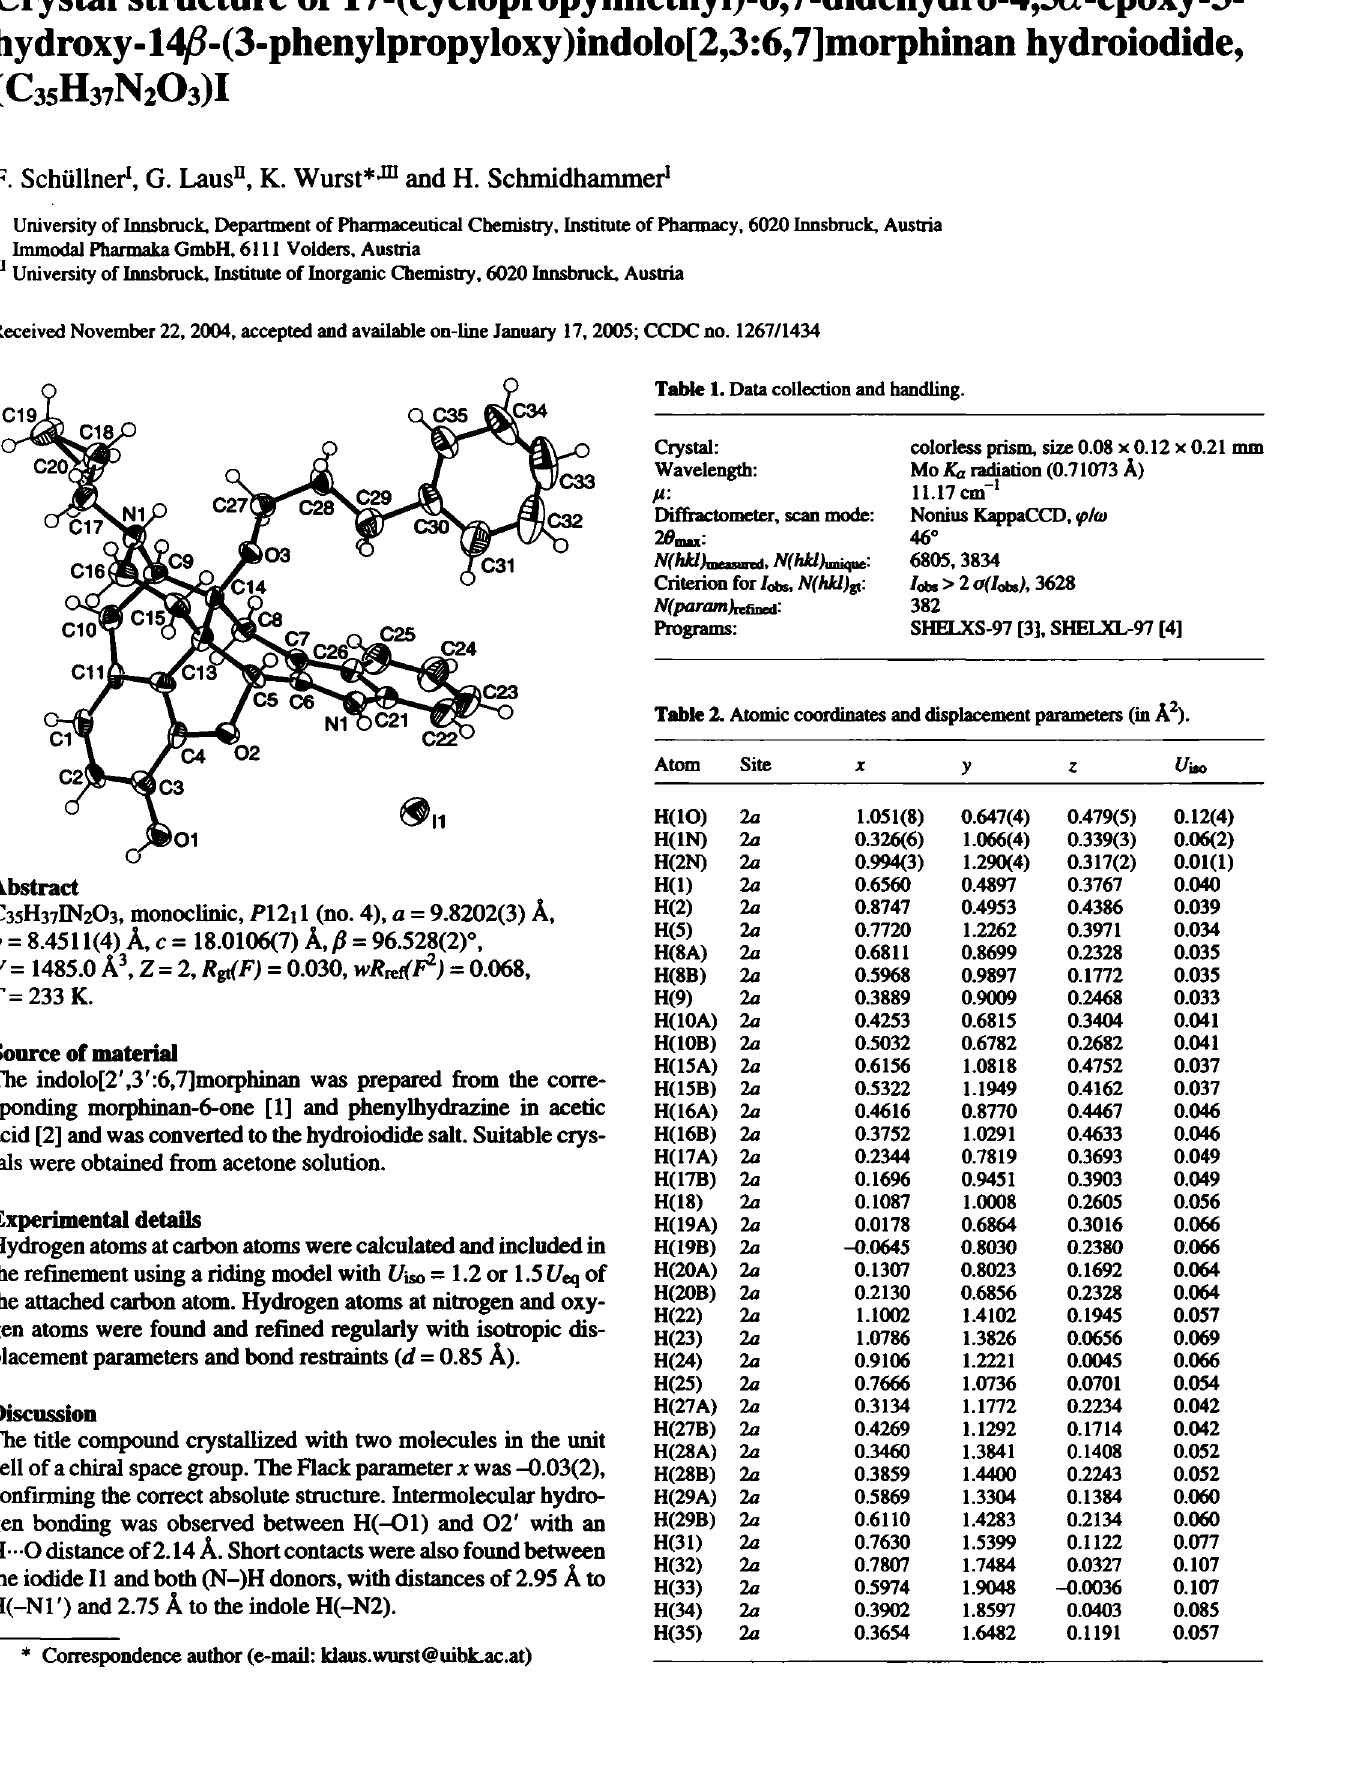
Table 1. Data collection and handling.